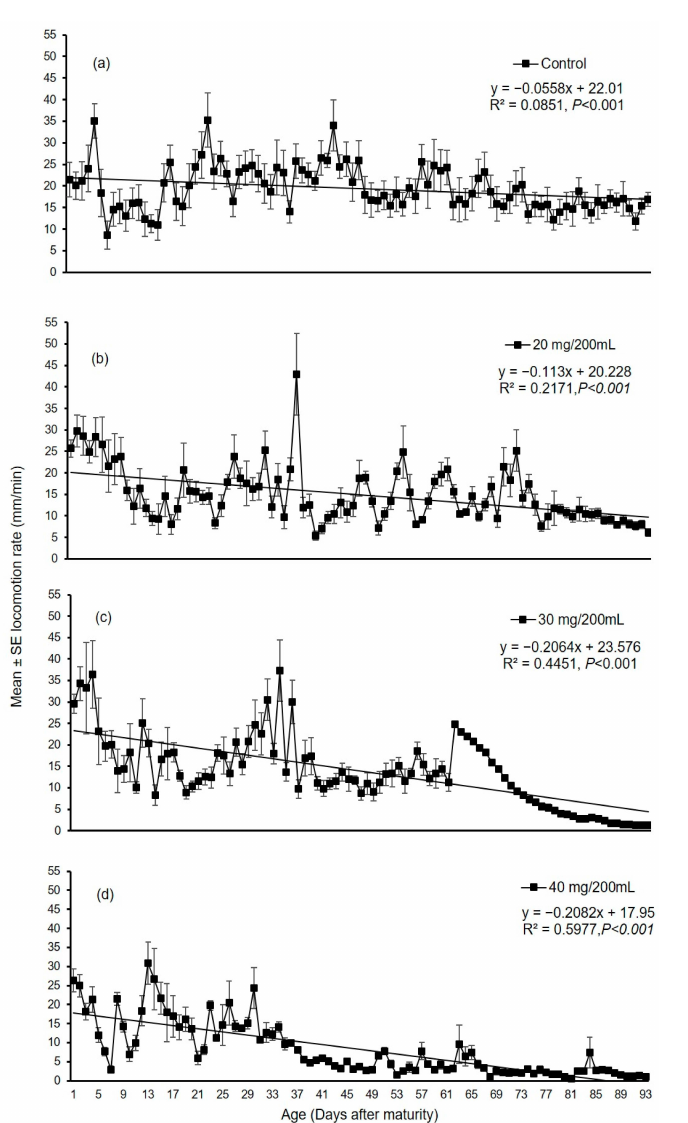
Figure 5. Age (post maturity) specific locomotion speed (mm/min) of P. acuta , in ( a ) control, and in